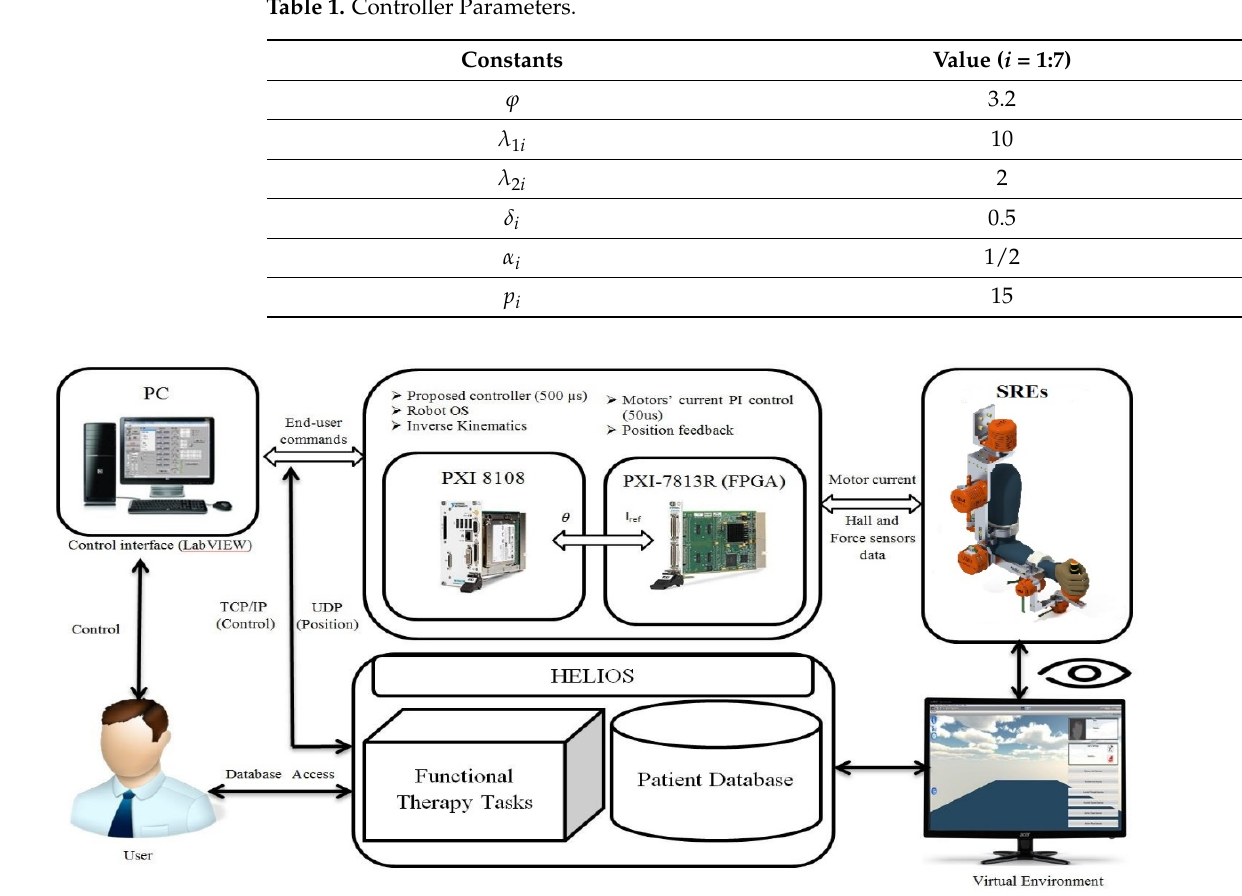
Figure 3. Controller setup.